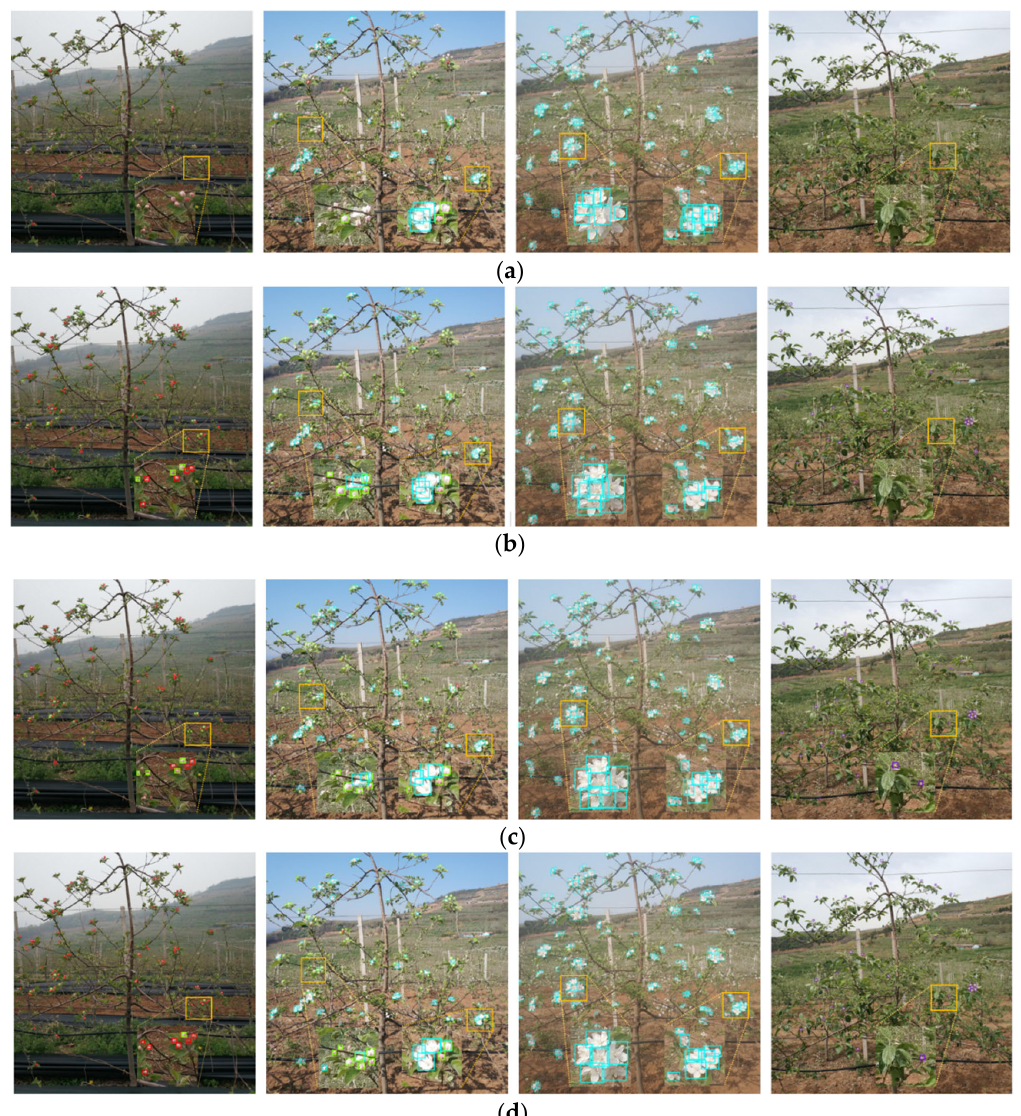
Figure 6. Detection of four growth stages of apple blossoms with red, green, blue, and purple boxes using different models. ( a ) YOLOX-s detection results; ( b ) S-YOLO-s detection results; ( c ) YOLOX-l (add SAHI) detection results; ( d ) S-YOLO-l detection results.